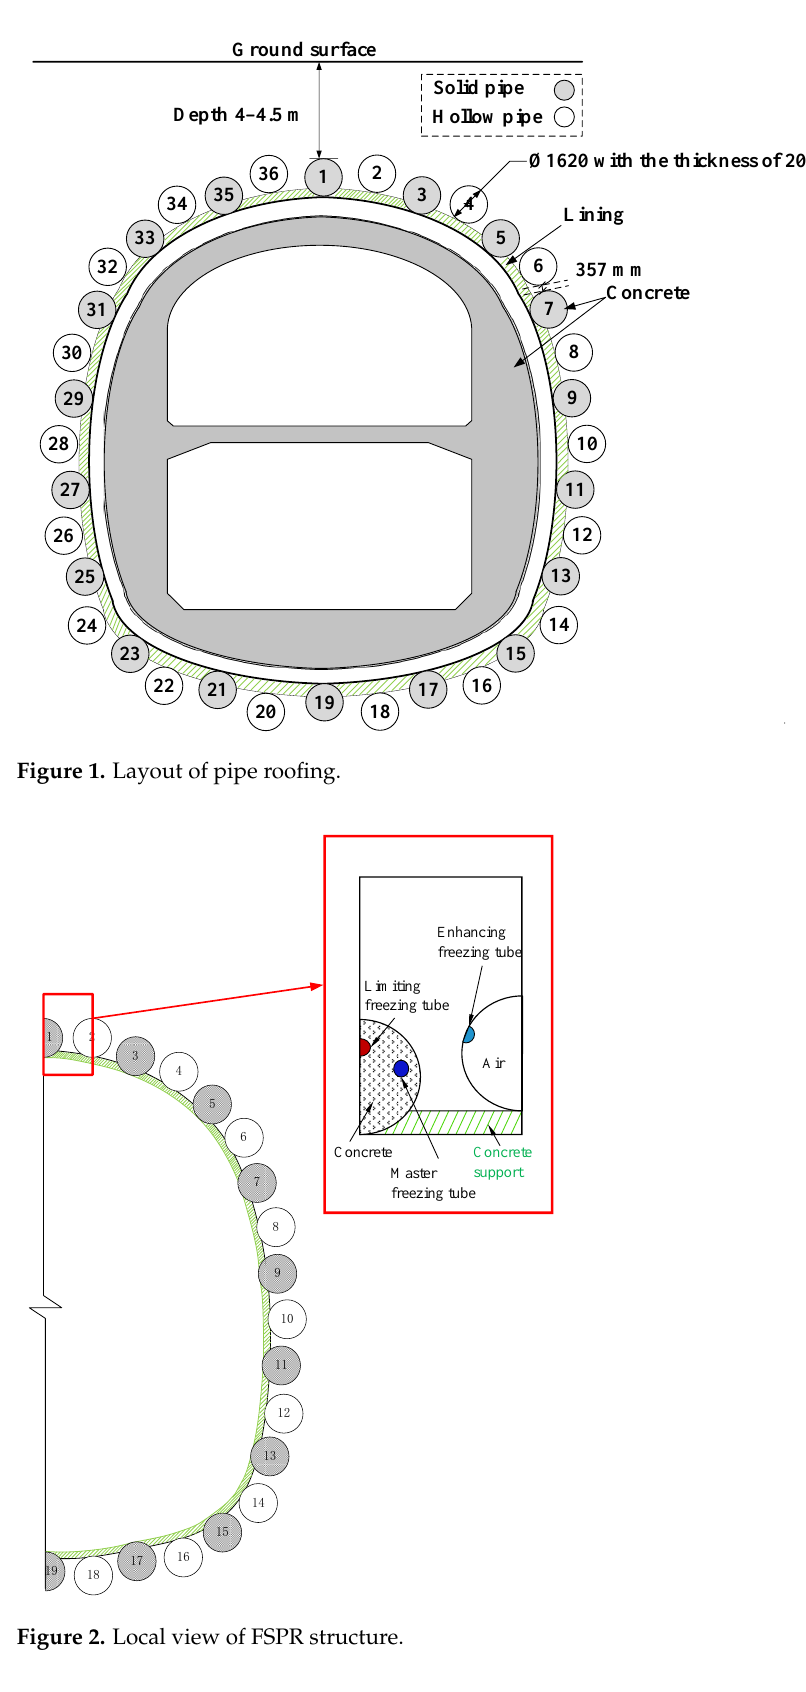
Figure 2. Local view of FSPR structure.